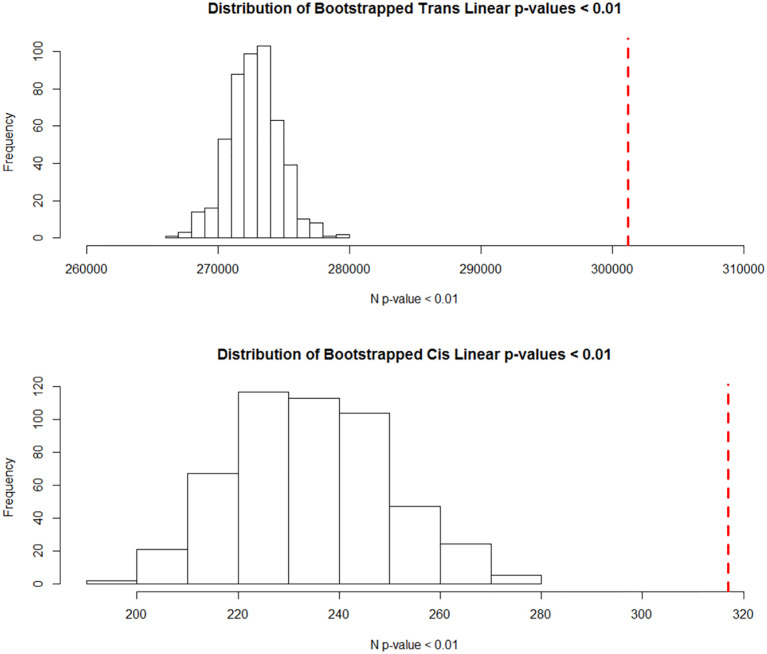
Distribution of bootstrapped low p-value counts.Histograms of the number of p-values below 0.01 in our 100 bootstrapped linear trans and cis-eQTLs analysis. The red dotted line represents the observed values. The likelihood of observing such extreme values by chance is essentially 0 in both cases, if we model the likelihood based of the normal distribution.